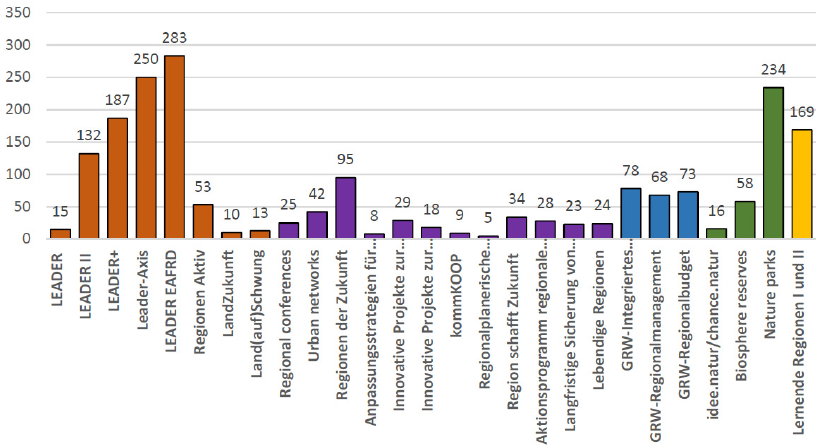
Figure 3. Number of assisted districts and towns with district status in the individual programmes (absolute numbers). x -axis: programmes: rural development policy (orange); spatial planning and regional development (purple); regional economic policy (blue); environment and nature protection (green); research and education (yellow); y -axis: number of assisted districts and towns with district status. Source: authors’ compilation (Department of Geography Giessen, Institute for Labour and the Economy Bremen).